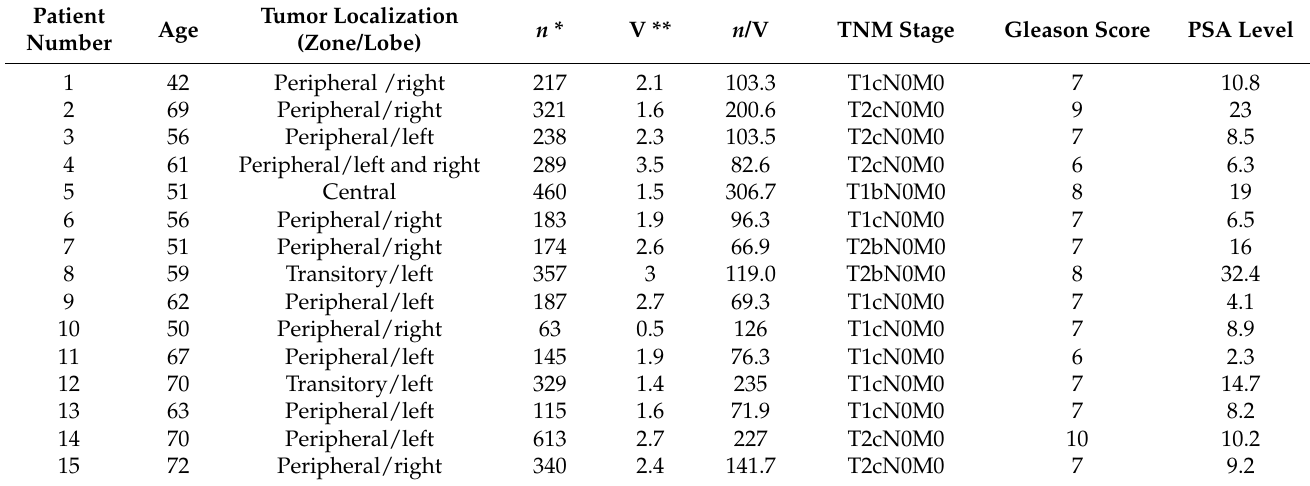
Figure 3. ( A , B ) The putative tumor cells overexpressing all three antigens of interest (PSMA, CK, and GPC-1) were considered CTCs. At the same time, a high number of the putative tumor cells significantly positive for one or two of the three antigens was also observed in the patients’ samples, representing potential antigen heterogeneity of the PCa tumor. ( C ) The MRI scan of one of the PCa patients’ prostates (white circle) showing the tumor (red circle) as the potential source of CTCs in the seminal fluid. Table 1. Number of isolated CTCs from SF samples and parameters of PCa in